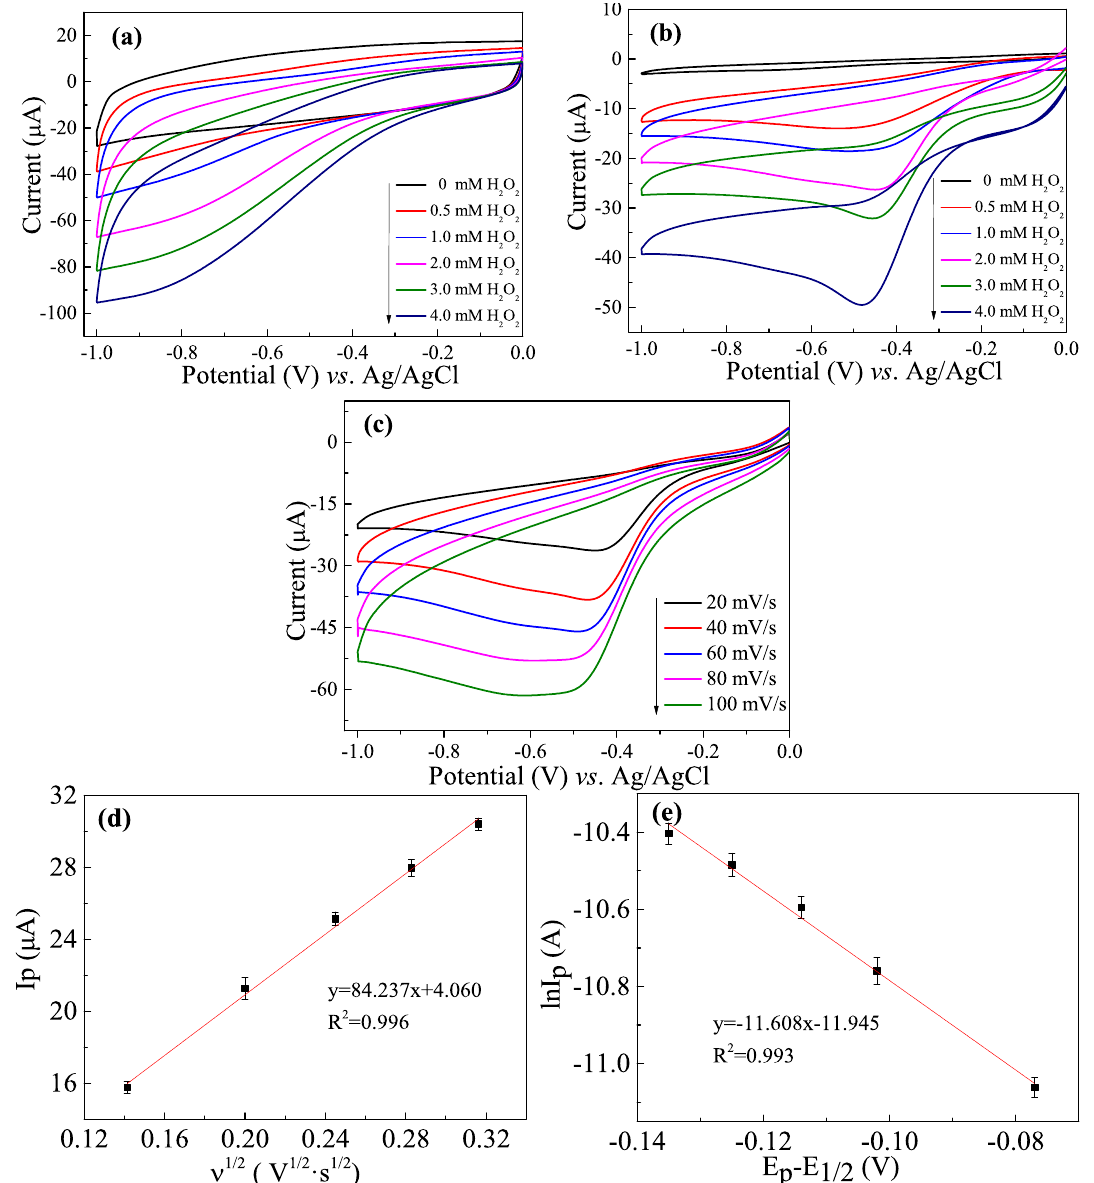
Figure 6. CVs of TiN/SMS ( a ) and Ag-TiN/SMS ( b ) electrodes at the scan rate of 20 mV ⋅ s −1 with addition different concentrations of H 2 O 2 (0, 0.5, 1.0, 2.0, 3.0, 4.0 mM); ( c ) CVs of Ag-TiN/SMS electrodes in the presence of 2 mM